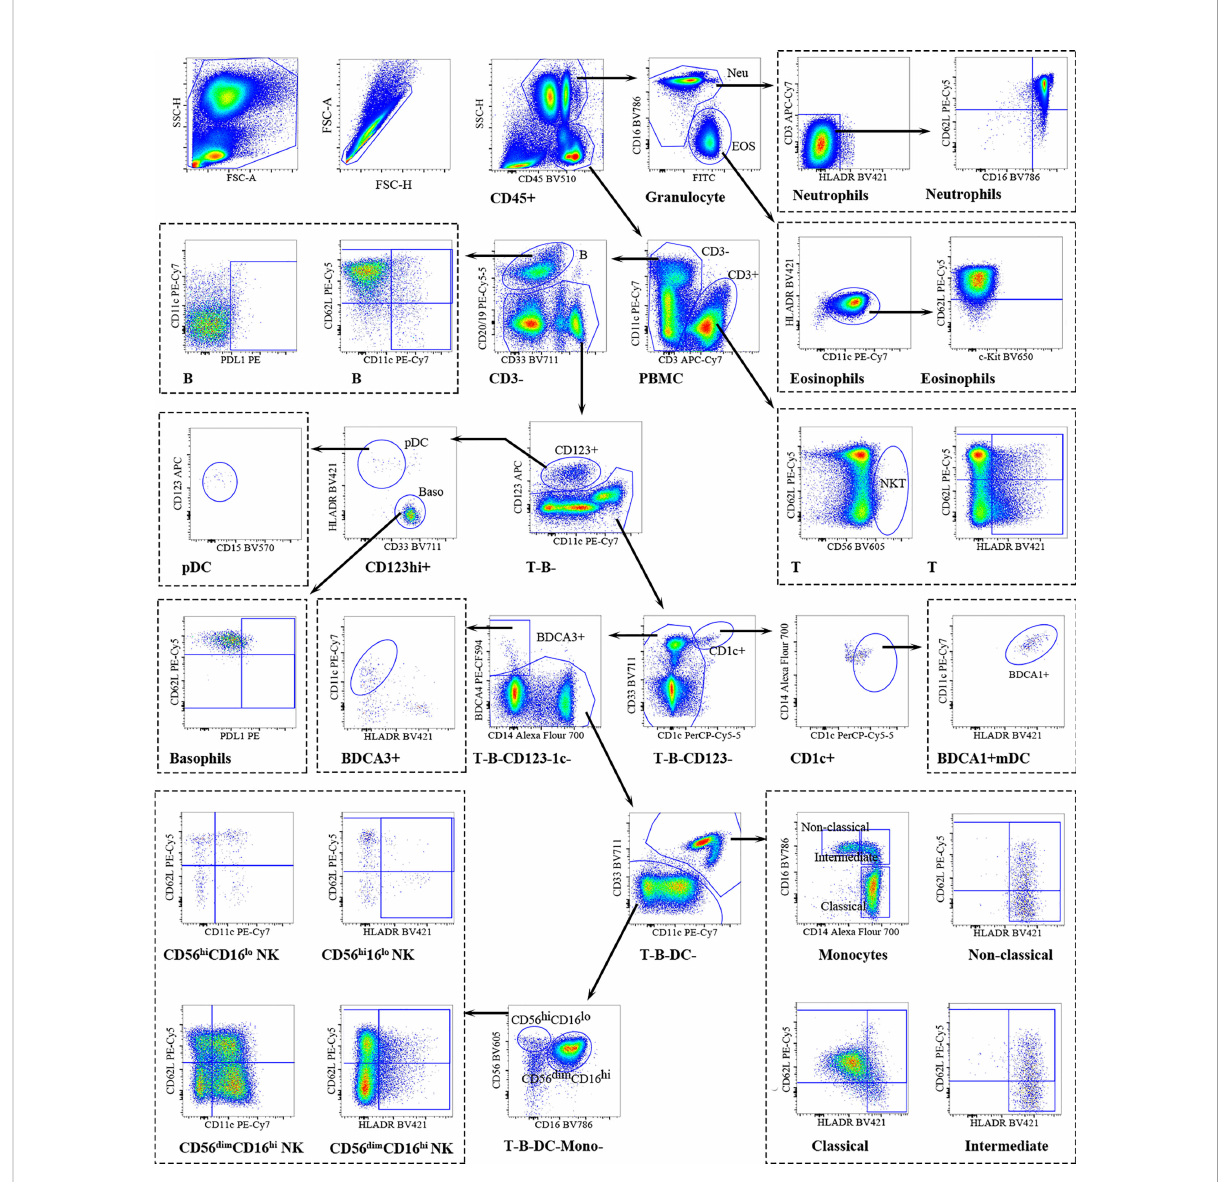
FIGURE 1 Overview of peripheral immune cells gating strategy. Representative polychromatic dot plots demonstrating the gating strategy used to identify peripheral immune cell content in RPL patients and HDs. All leukocytes were selected using CD45- positivity and then divided into separate cell subtypes as